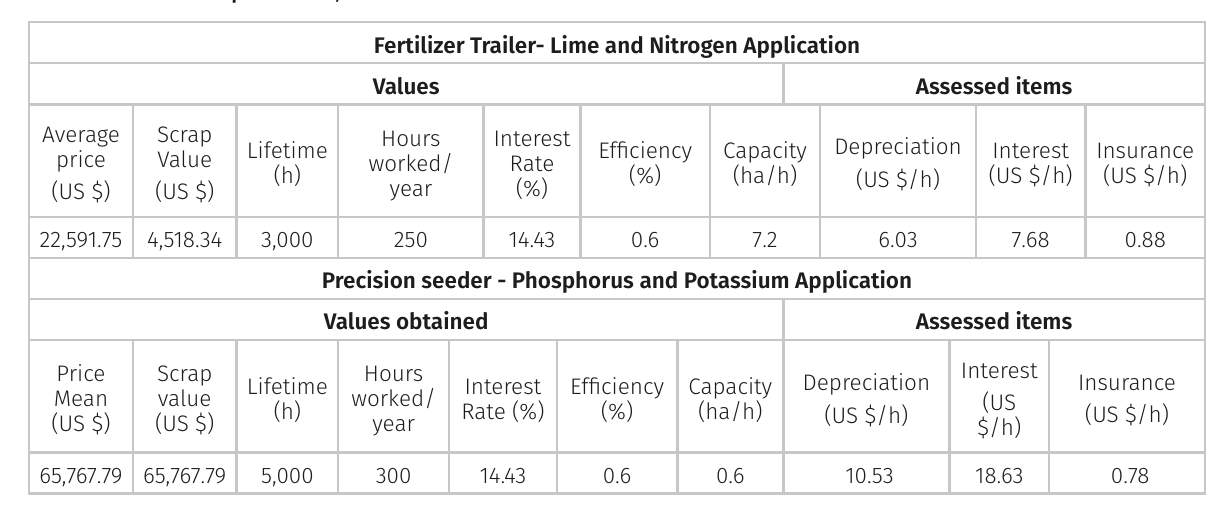
Table II. Costs of depreciation, interest and